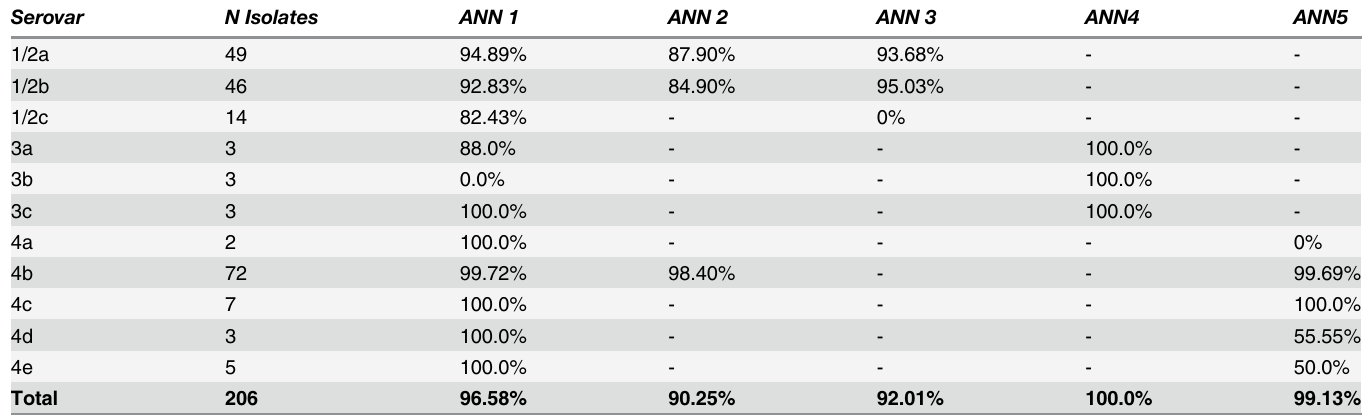
Table 2. Eleven serovars of Listeria monocytogenes were used to form multiple artificial neural networks. Percentages show correct identification. Groupings based on somatic O antigens and trends in public safety. Serovar N